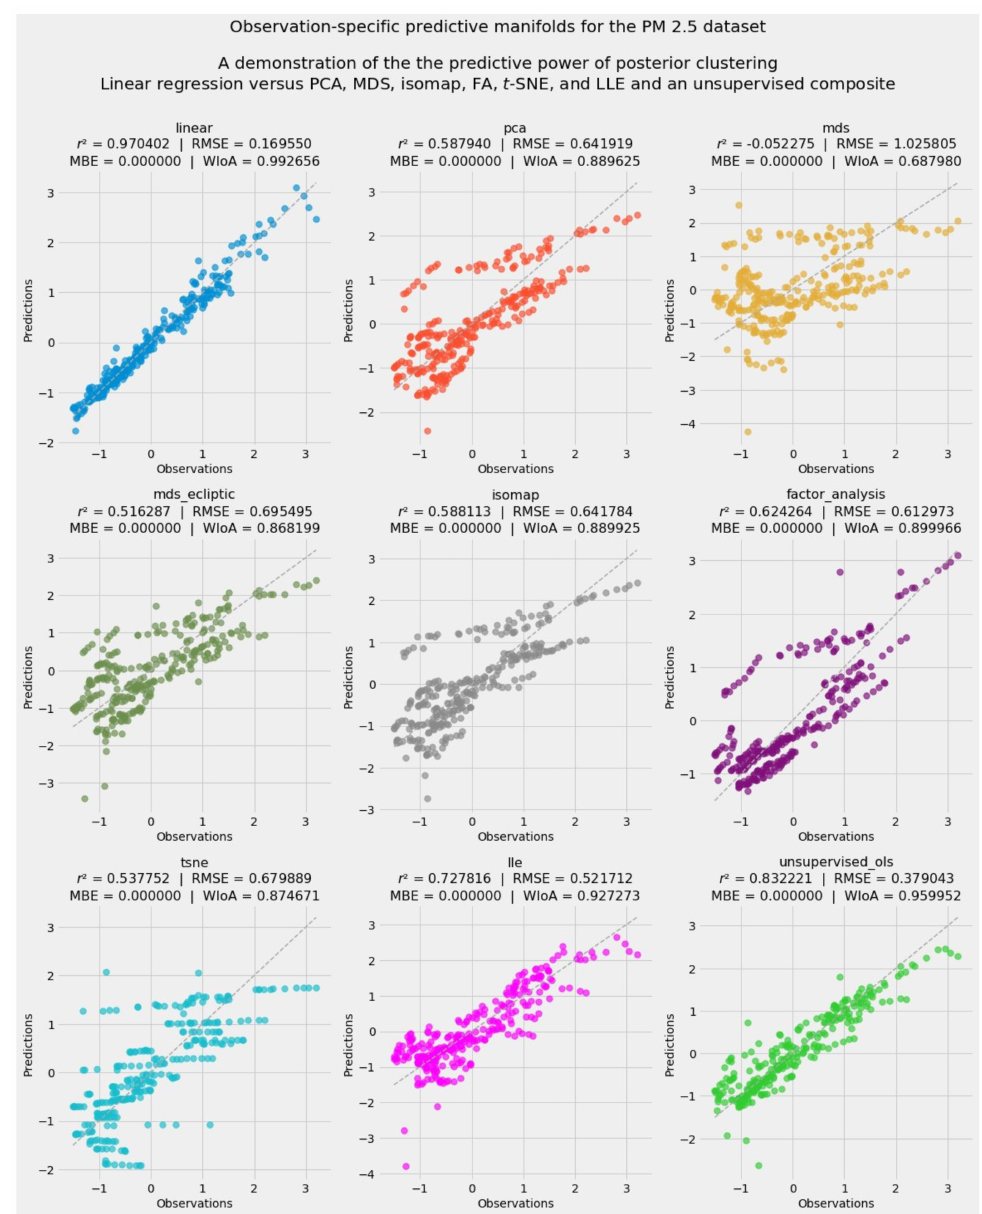
Figure 13. Baseline performance for predictive manifolds, based on the naïve, equally weighted array of predictive